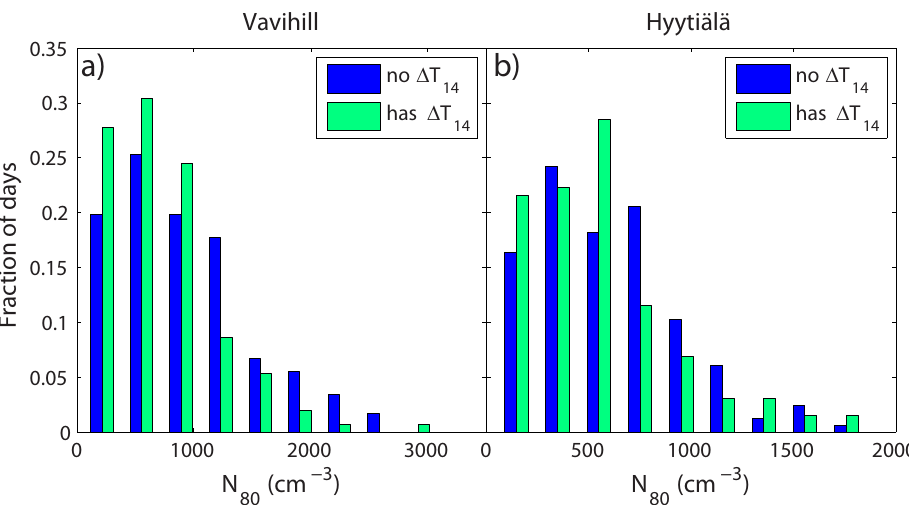
Fig. 5. Histogram of N 80 levels for cases with profiles that reach 14µm (has 1T 14 ) and profiles that do not reach 14µm (no 1T 14 ) for Vavihill (a) and Hyytiälä (b)